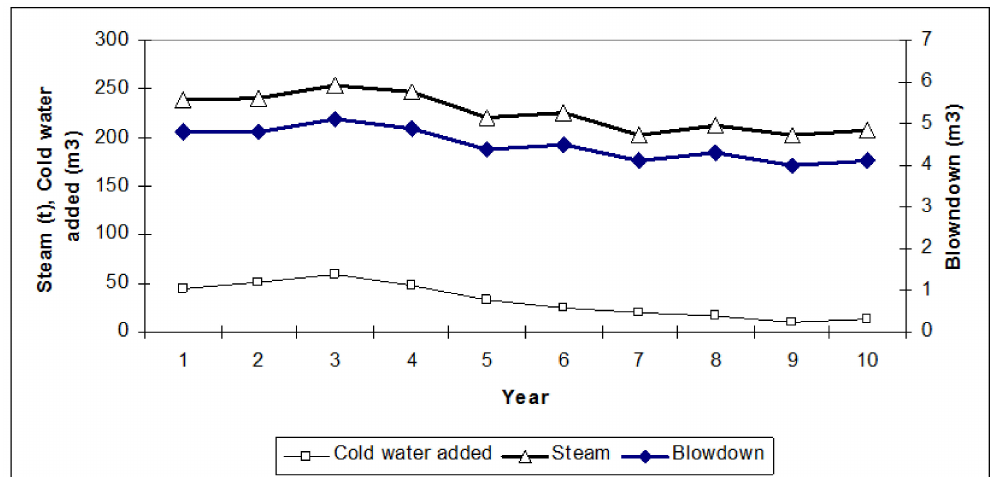
Figure 2. Daily average steam production and cold water added to the circuit due to boiler blowdown.